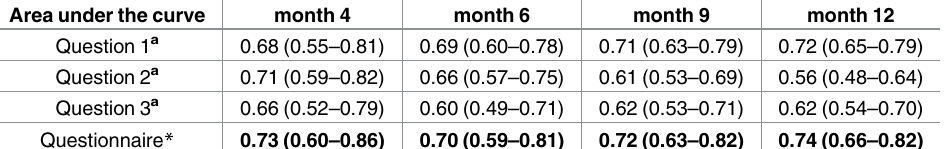
Table 5. Area under the ROC curve for every studied question and for the questionnaire, at everyfol- low-up period. Area under the